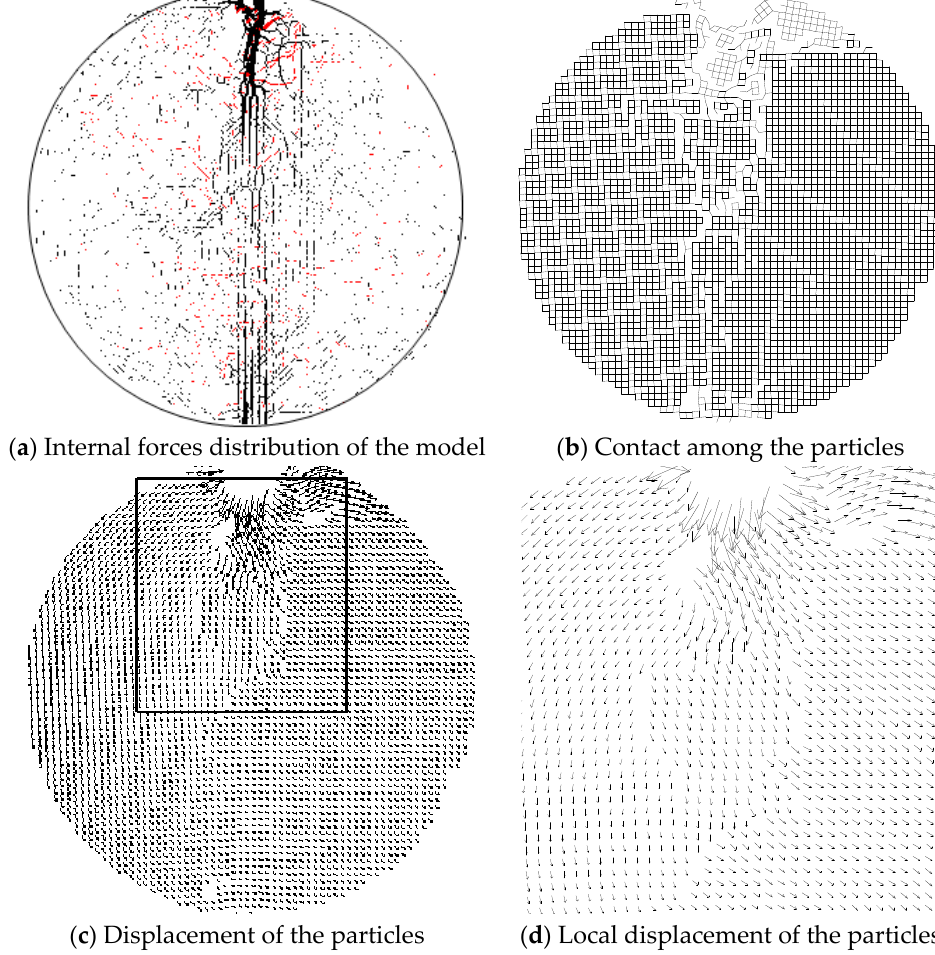
Figure 11. Interconnected crack.